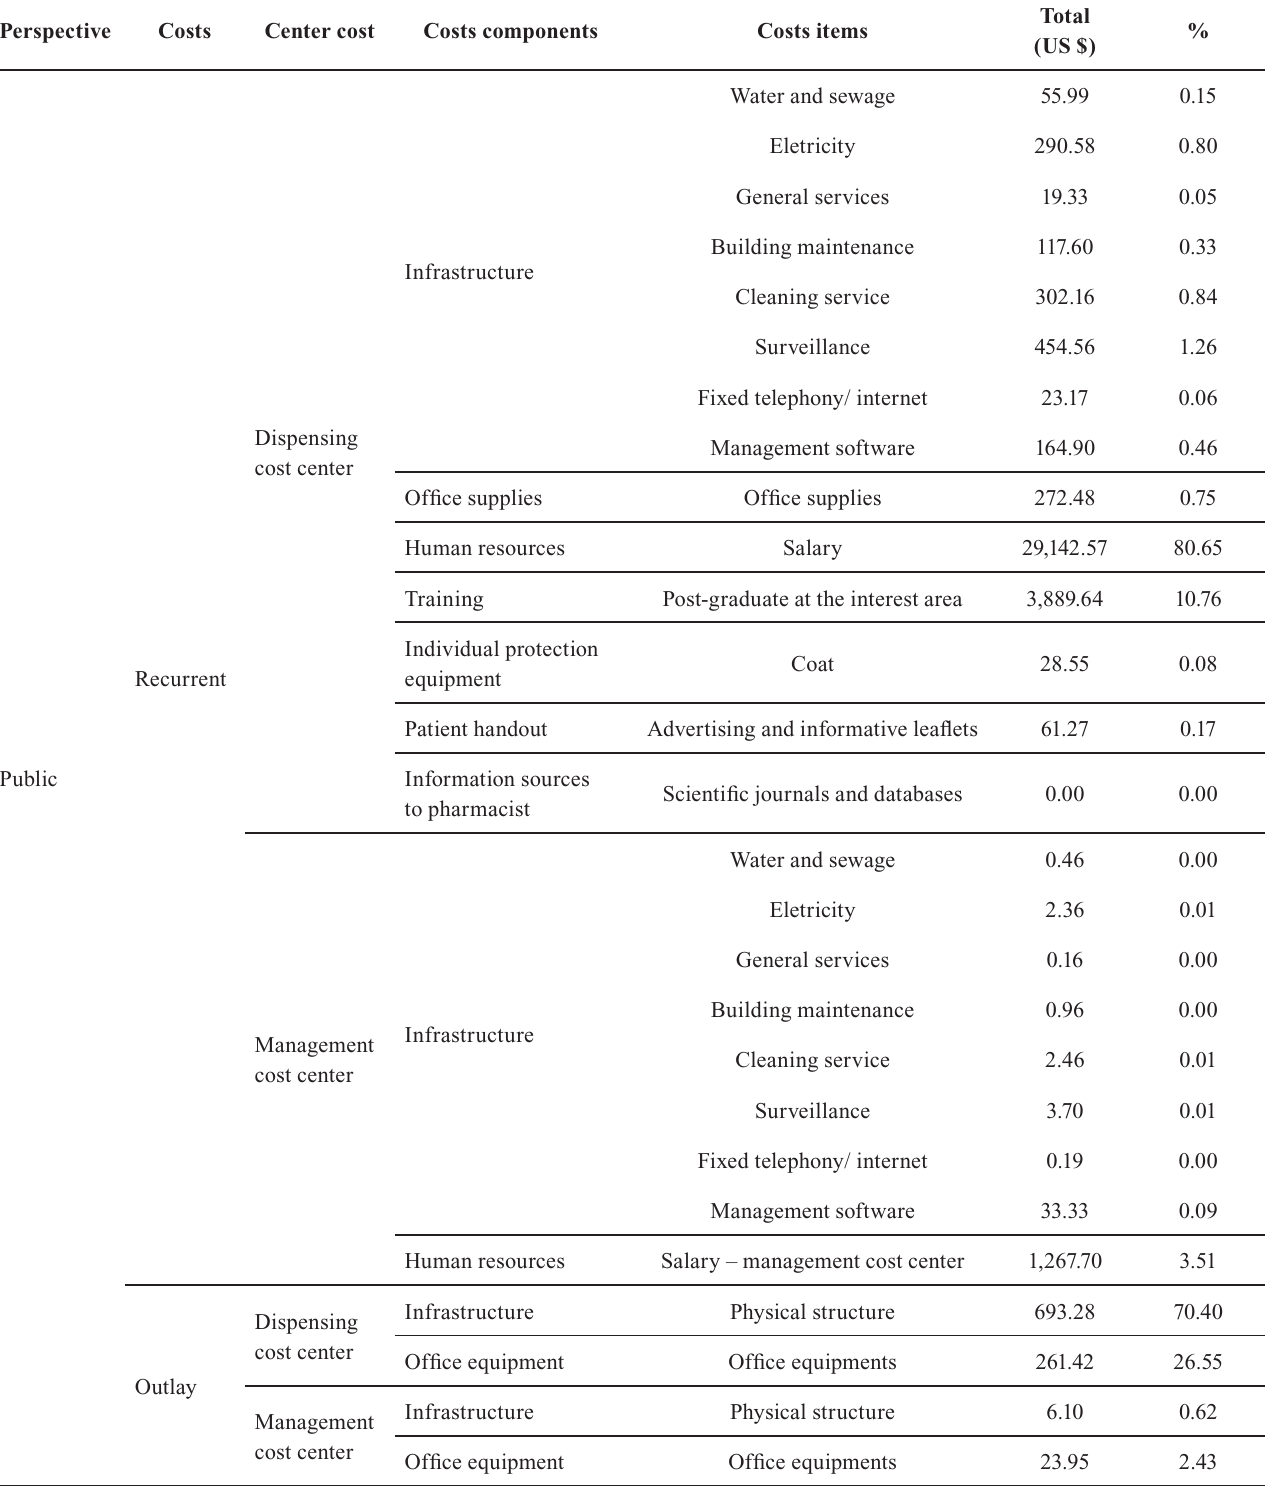
TABLE IV – Costs per centers costs of medicine dispensing service per perspective and service situation